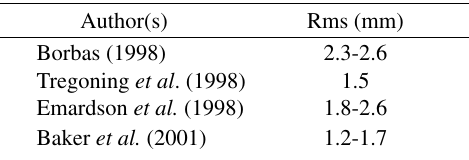
Table I. Rms (mm) between PW by GPS and PW by radiosounding reported by other